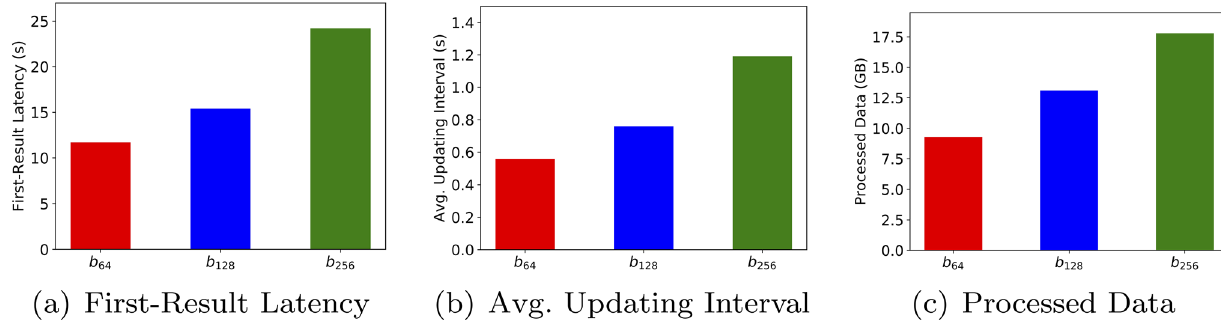
Fig. 8 Performance on different block